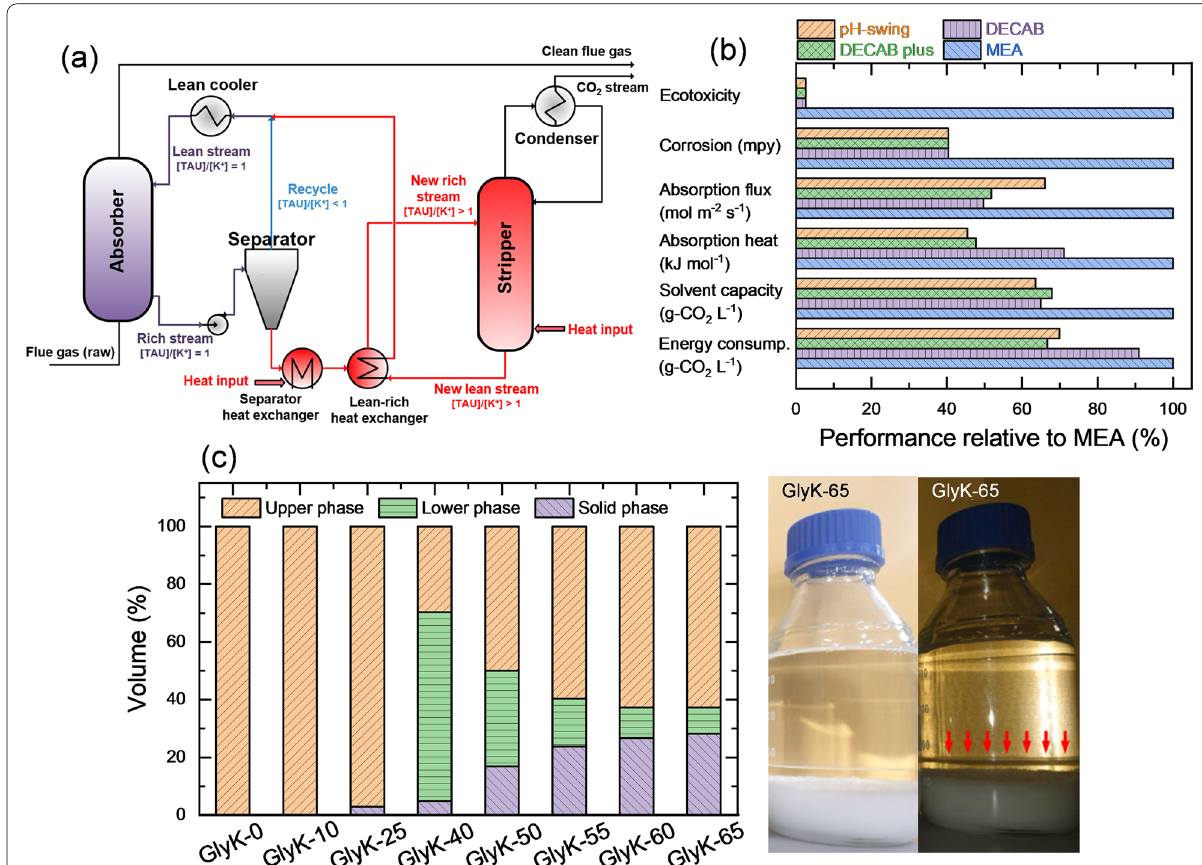
Fig. 5 a Process flow diagram of DECAB‑plus process using potassium taurate as CO 2 capturing agent (Reproduced with permission from [43]. Copyright 2013 American Chemical Society). b Comparison of DECAB processes with conventional MEA capturing technology (Reproduced from [38] with permission from Elsevier). c Effect of DMF/water ratio on the volume of solid–liquid‑liquid phase separation of potassium glycinate (GlyK‑65 stands for 65 v/v% DMF) (Reproduced from [44] with permission from